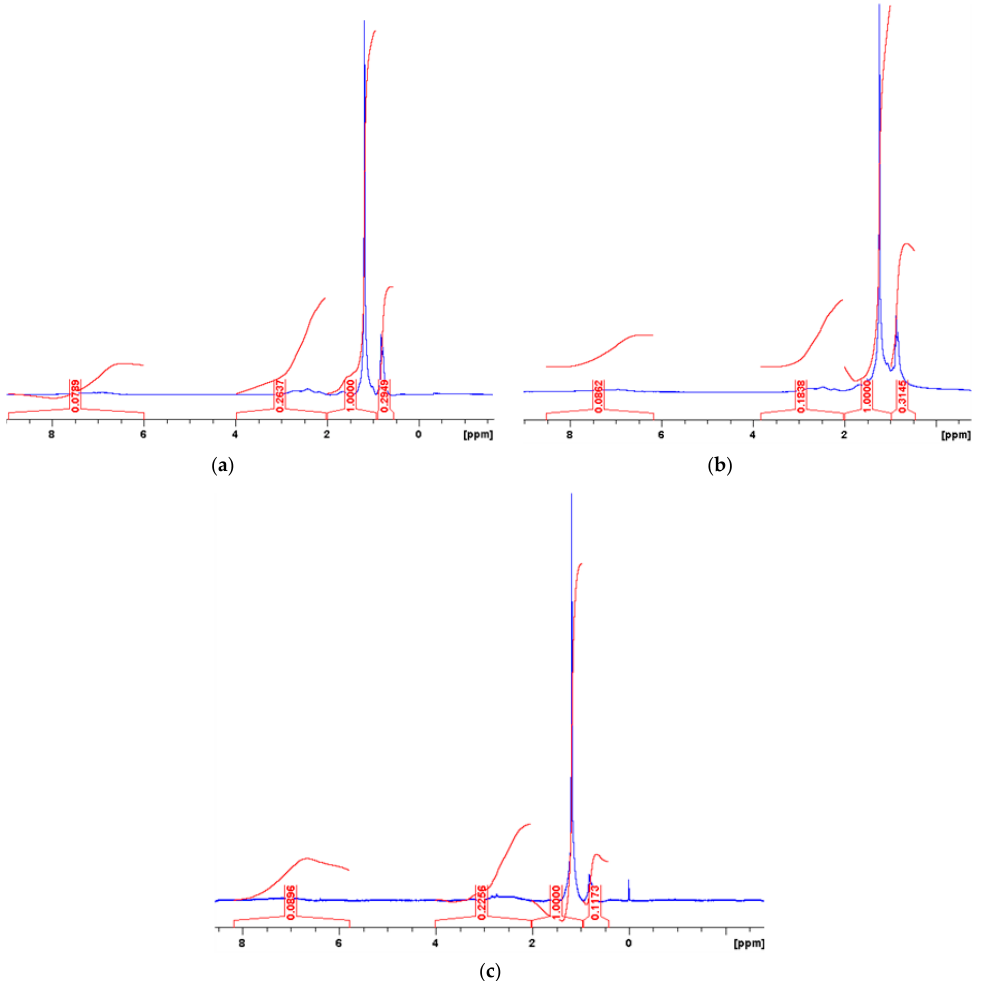
Figure 4. The 1 H-NMR spectra of Paving 70/100 bitumen in CCl 4 : ( a ) neat bitumen; ( b ) maltene fraction; and ( c ) asphaltene fraction.